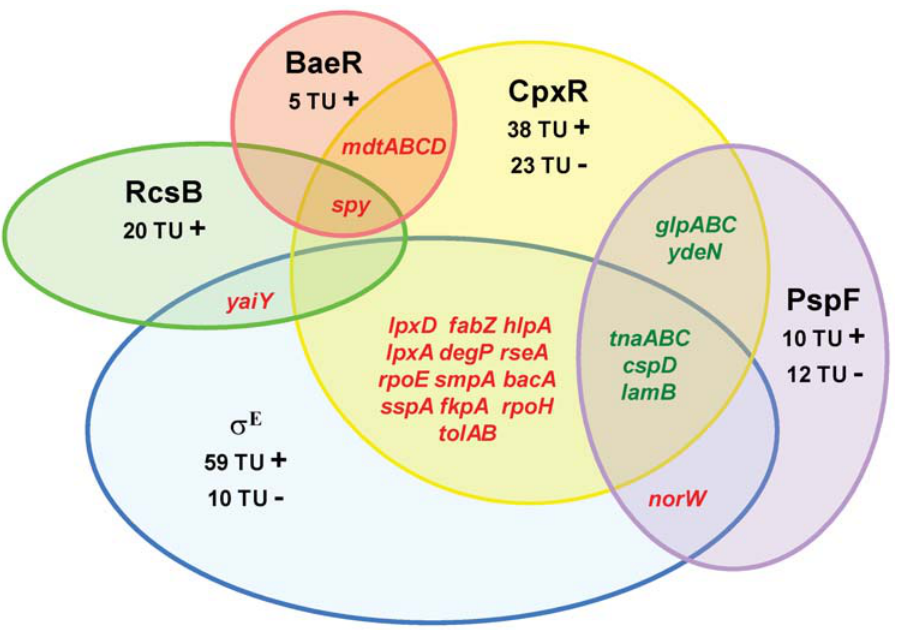
Figure 2. Venn diagram representation of all five extracytoplasmic response pathways. The total number of genes/operons (i.e. transcription units; TU) affected in each condition, positive ( + ) and negative ( 2 ) regulation found in the present study, is indicated for each regulon. The Cpx regulon comprises genes affected by CpxR overproduction or deletion (genes repressed or induced by the absence of cpxR are counted + and 2 , respectively). Only genes that are common to at least two regulons and confirmed by qRT-PCR and/or the literature are listed (red: induced, green: repressed). Genes described in the literature as dependent on CpxR and s E or BaeR are also included.